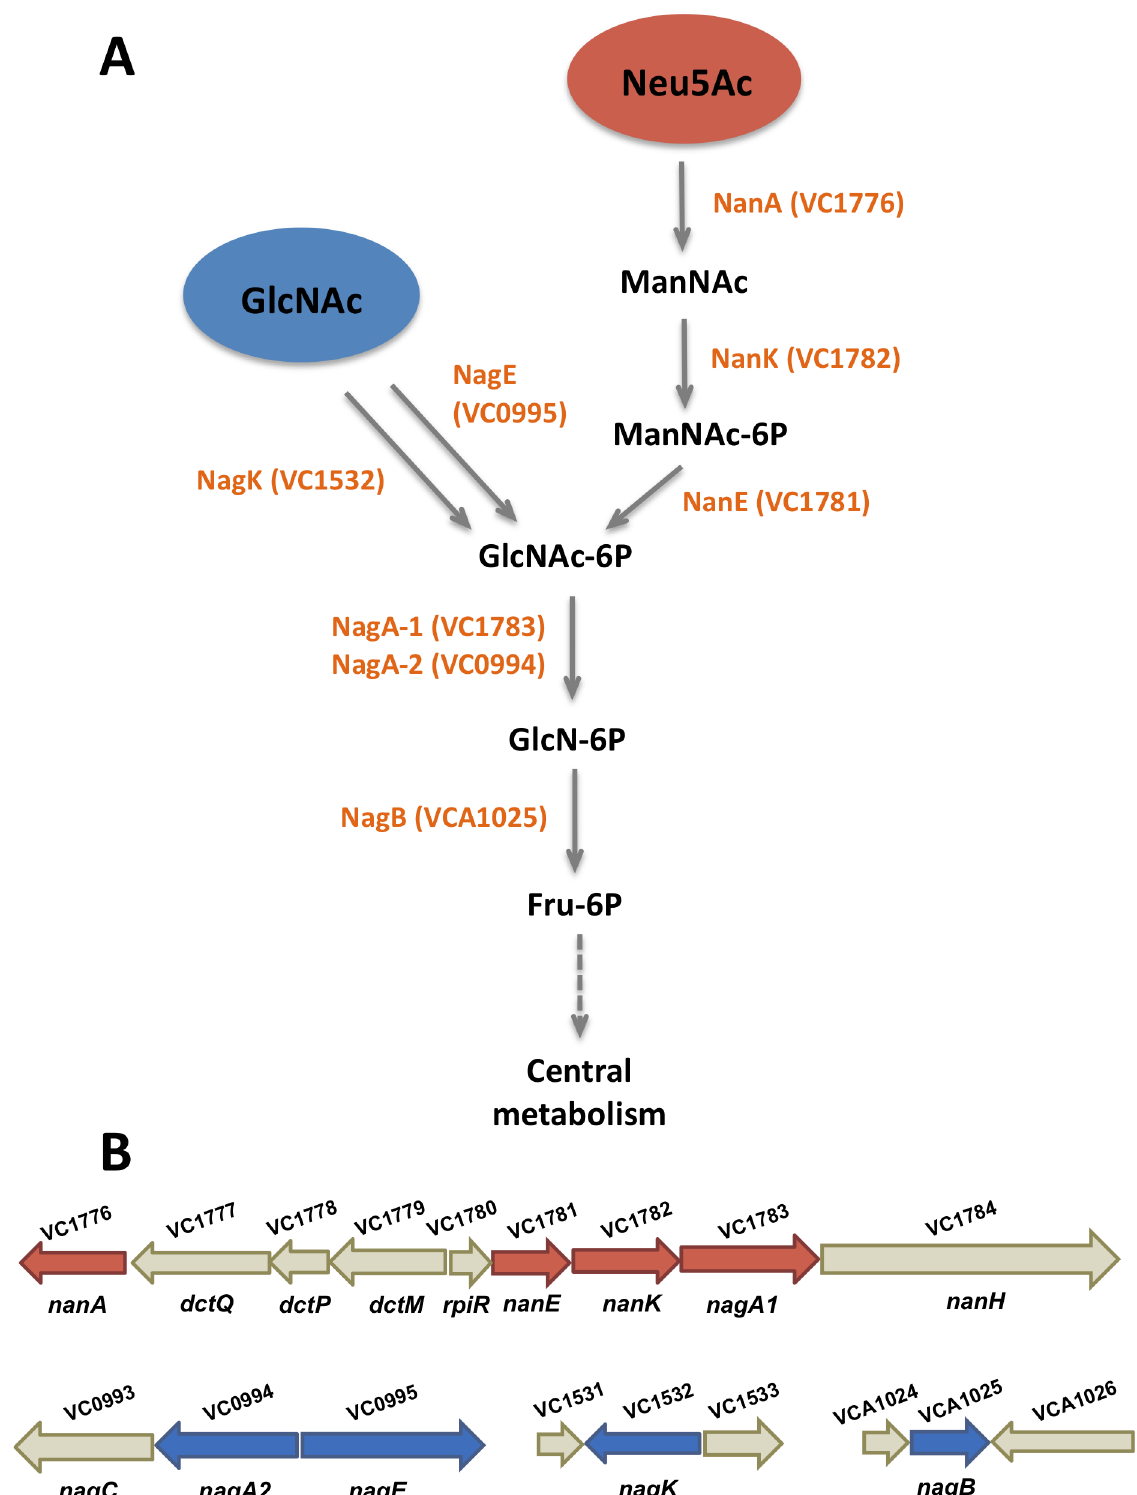
Fig 2. Schematic of Neu5Ac and GlcNAc catabolic pathways. A) The catabolic pathway of N -acetylneuraminic acid (Neu5Ac, red circle) converges with the catabolic pathway of N -acetylglucosamine (GlcNAc, blue circle) through the production of three common catabolites: N - acetylglucosamine-6-phosphate (GlcNAc-6P), glucosamine-6-phosphate (GlcN-6P) and fructose-6-phosphate (Fru-6P). Abbreviations are as